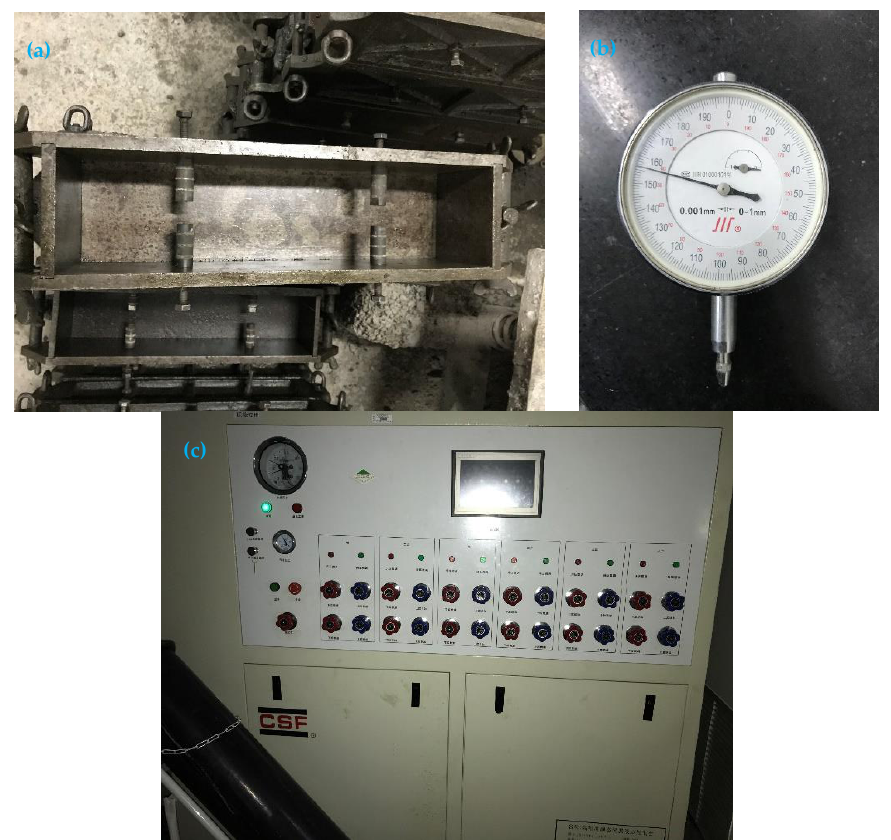
Figure 2. Laboratory apparatus: ( a ) embedded probe; ( b ) micrometer gauge; ( c ) static servo hydraulic creep loading